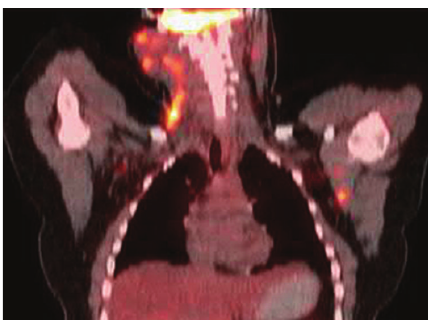
Figure 1: Positron Emission Tomography, Computed Tomography Scan. Fusion PET/CT demonstrating diffuse right cervical and left axillary